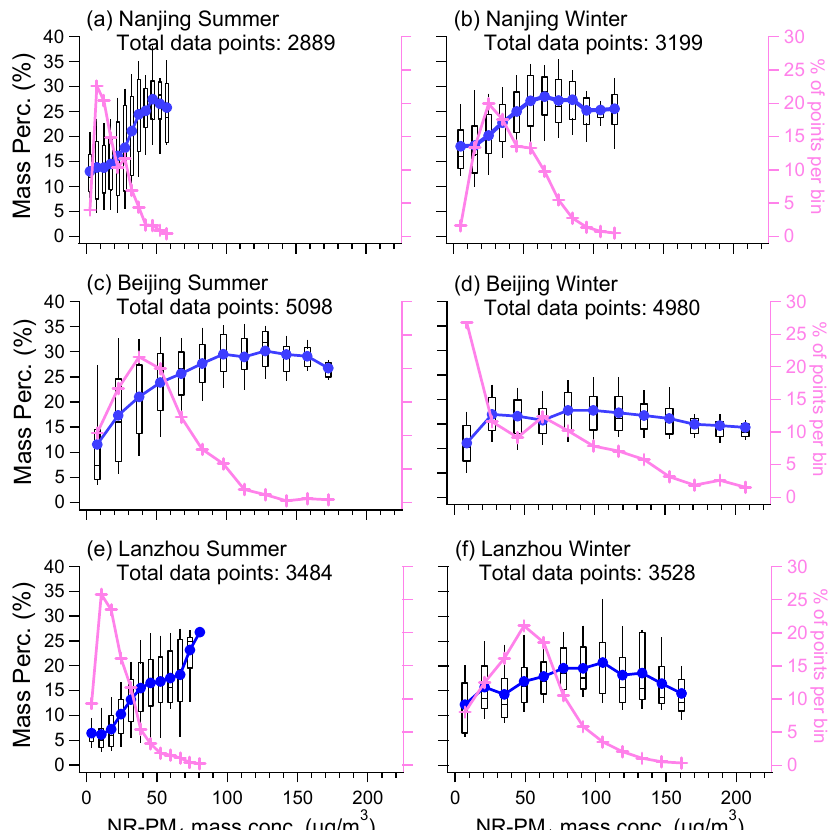
Figure 4. Variations of the mass percentages of nitrate as a function of the total non-refractory PM 1 (NR-PM 1 )concentrations (left y axis, note the NR-PM 1 did not include r BC for all datasets in this figure), and the percentage of data points in each bin (right y axis): ( a ) Nanjing summer, ( b ) Nanjing winter, ( c ) Beijing summer, ( d ) Beijing winter, ( e ) Lanzhou summer, and ( f ) Lanzhou winter (the box plot symbols are the same as those described in Figure 1; note Figure 4c–f are reproduced and modified from previous studies [28,29,31,32]).